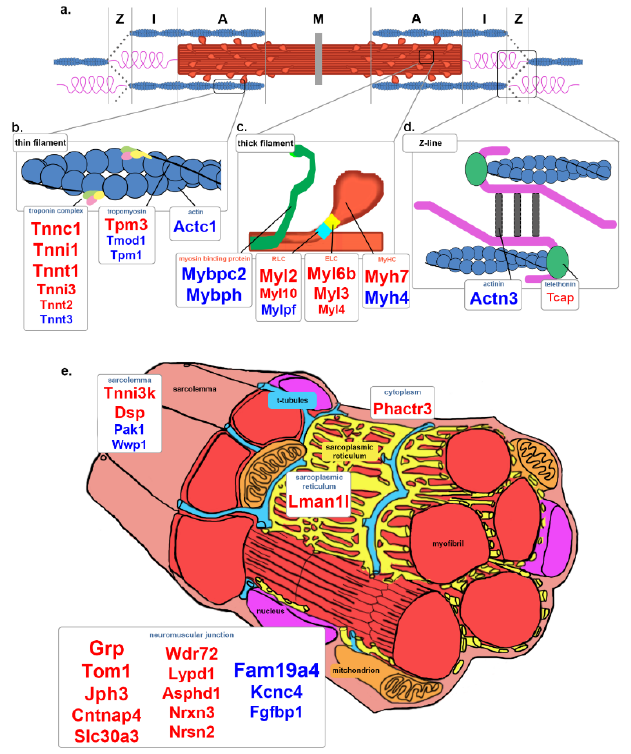
Figure 5. Contraction-related genes in So and Ta. ( a ) Graphic representation of the sarcomere. The M-line, A-zone, I-zone, and Z-line are depicted. The red band represents the thick myosin filament. The blue spheres represent the thin filament. Within the I-zone, resides an elastic protein called titin. ( b ) Graphic representation of thin filament structure. Tpm3, Tnnc1, Tnni1, Tnnt1, Tnni3, Tnnt2 , and Tnnt3 were increased in So. Actc1, Tmod1, Tpm1 , and Tnnt3 were increased in Ta. ( c ) Thick filament close-up. Myh7, Myl6b, Myl3, Myl4, Myl2 , and Myl10 were increased in So. Myh4, Mylpf, Mybpc2 , and Mybph were increased in Ta. ( d ) Z-line close-up. The Z-line region of the sarcomere is where actin and titin are connected to an antiparallel complex, including titin cap ( Tcap ) and actinin ( Actn3 ). ( e ) Myofiber structure. Jph3, Lman1l, Phactr3, Tnni3k, Dsp, Grp, Tom1, Cntnap4, Slc30a3, Wdr72, Lypd1, Asphd1, Nrxn3 , and Nrsn2 were increased in So. Pak1, Wwp1, Fam19a4, Kcnc4 , and Fgfbp1 were increased in Ta. Red or blue gene symbols underneath structure names represent in- creased expression in So or Ta, respectively. Font size correlates to relative FC. 4. Discussion Two broad-scale patterns emerged along with the three categories of overrepre- sented molecular pathways when examining the gene expression profiles of So and Ta muscles (Figure S1). First, DE genes involved in lipid, glucose, and glycogen metabolism pathways associated more with one muscle than the other (Tables 1 and 2). Second, each muscle expressed unique genes encoding for similarly functioning isoenzymes, particu- larly for genes involved in the contraction and ion transport categories (Table 3 and Table S1). We put these differences into context below, starting with the pathways that differen- tiate the muscle types. DE genes with the highest FC difference were not prevalent among genes associated with the overrepresented pathways. Therefore, DE genes with a greater than 20-fold expression difference were included for further investigation. Similarly seen in a previous study [54], we found that approximately 10% of DE transcripts were mainly related to fatty acid metabolism, structural components, and neuromuscular junction as- sembly.